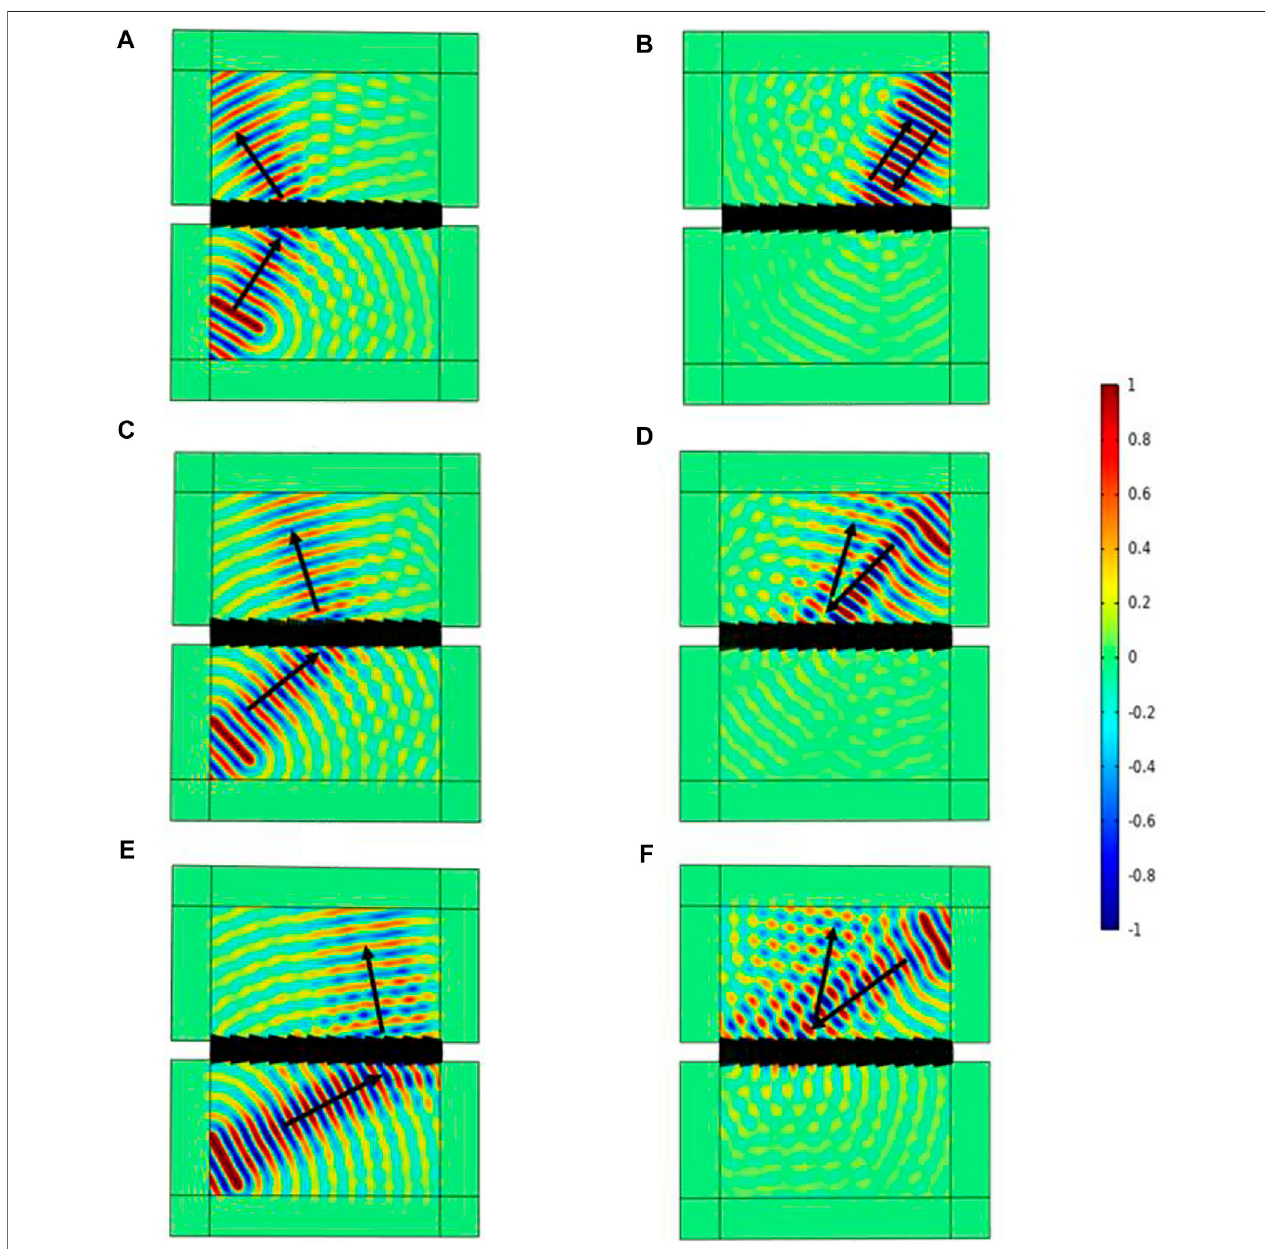
FIGURE 9 | Wide-angle asymmetric transmission of incident waves: (A) lower left corner -30 ° (B) upper right corner 30 ° ; (C) lower left corner -45 ° (D) upper right corner 45 ° ; (E) lower left corner - 60 ° (F) 60 ° to the upper right corner.